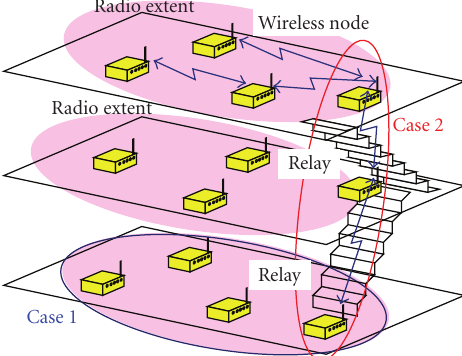
Figure 8: Measurement configuration in a building as mixture of Cases 1 and 2.